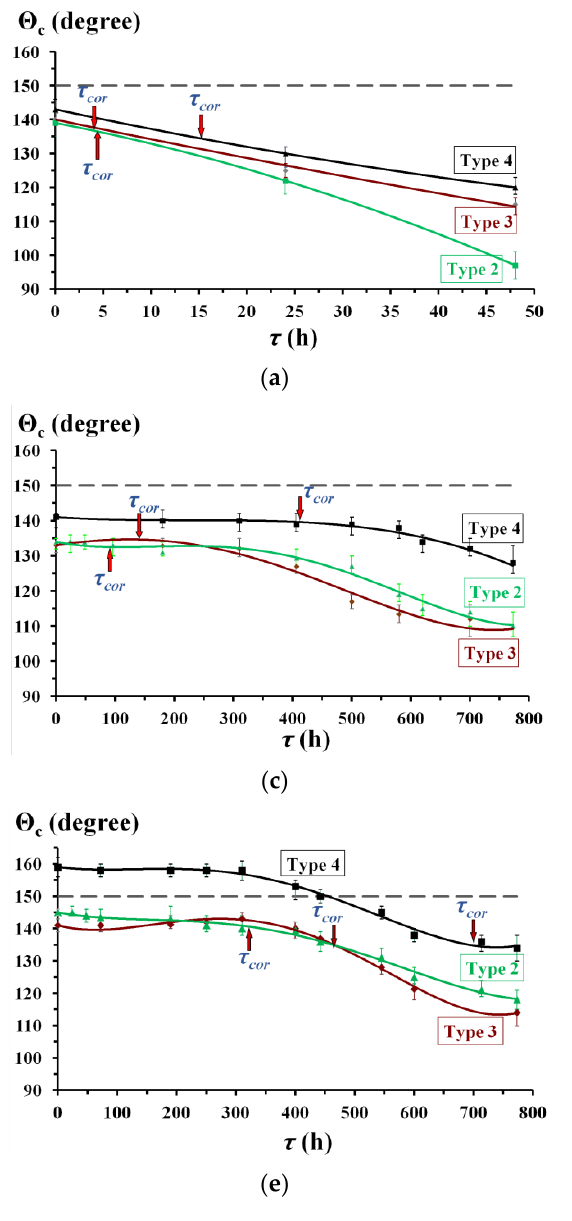
Figure 5. Change in the Θ c value with time ( τ ) on textured surfaces of zinc samples (Type 2–4) after layer-by-layer treatment in solutions of OCIs: ( a )—without treatment with OCIs; ( b )—2.5 mM SDDP; ( c )—10.0 mM VTMS; ( d )—10.0 mM OTES; ( e )—2.5 mM SDDP///10.0 mM VTMS; ( f )—2.5 mM SDDP///10.0 mM OTES.